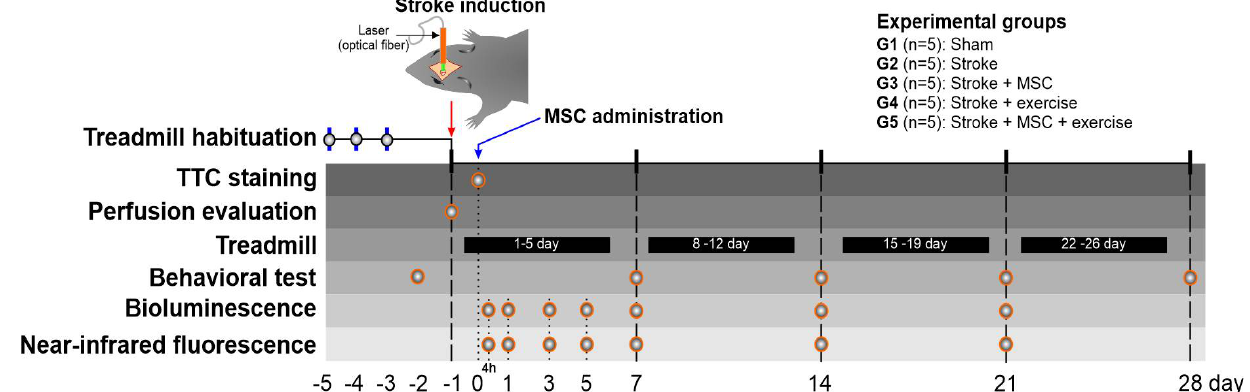
Figure 1. The experimental design included the temporal distribution of pre- and post-stroke induction evaluations, as well as the experimental groups (G1–G5). Treadmill habituation at −4, −3, −2 days before stroke induction, TTC staining at 1 day after stroke induction, perfusion evaluation pre- and post-stroke induction, treadmill physical training for 4 weeks (5 days per week), behavioral testing at −1 (control), and 7, 14, 21, and 28 days. At 4 h (28 h after stroke induction), and 1, 3, 5, 7, 14, and 21 days following MSC delivery, bioluminescence and near-infrared fluorescence were observed. Abbreviations: TTC (2,3,5-triphenyltetrazolium chloride staining); MSC (mesenchymal stem cells).